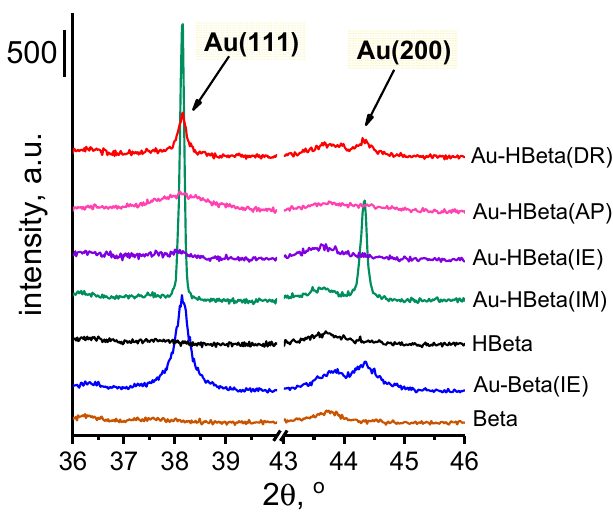
Figure 2. XRD patterns of zeolites presenting diffraction peaks originating from metallic gold.